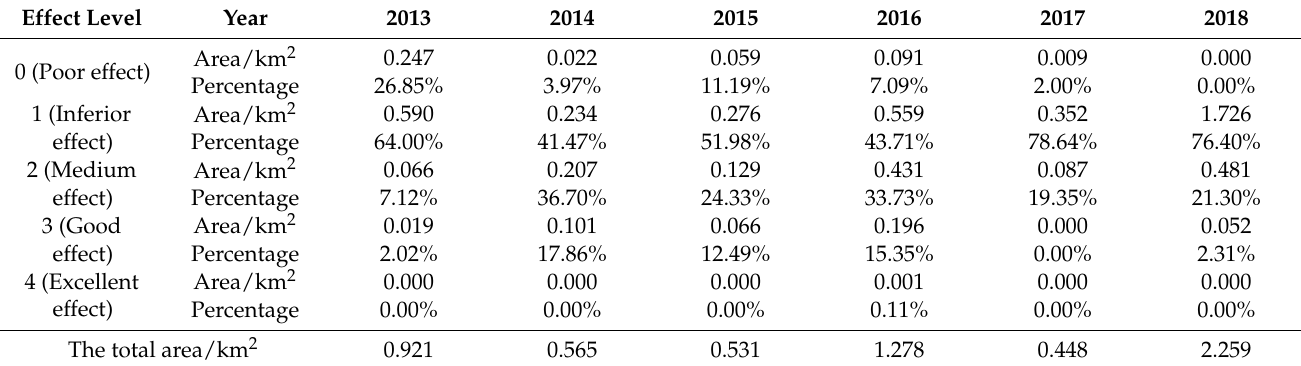
Table A4. Statistics on the effects of restoration vegetation from 2013 to 2018 in the study